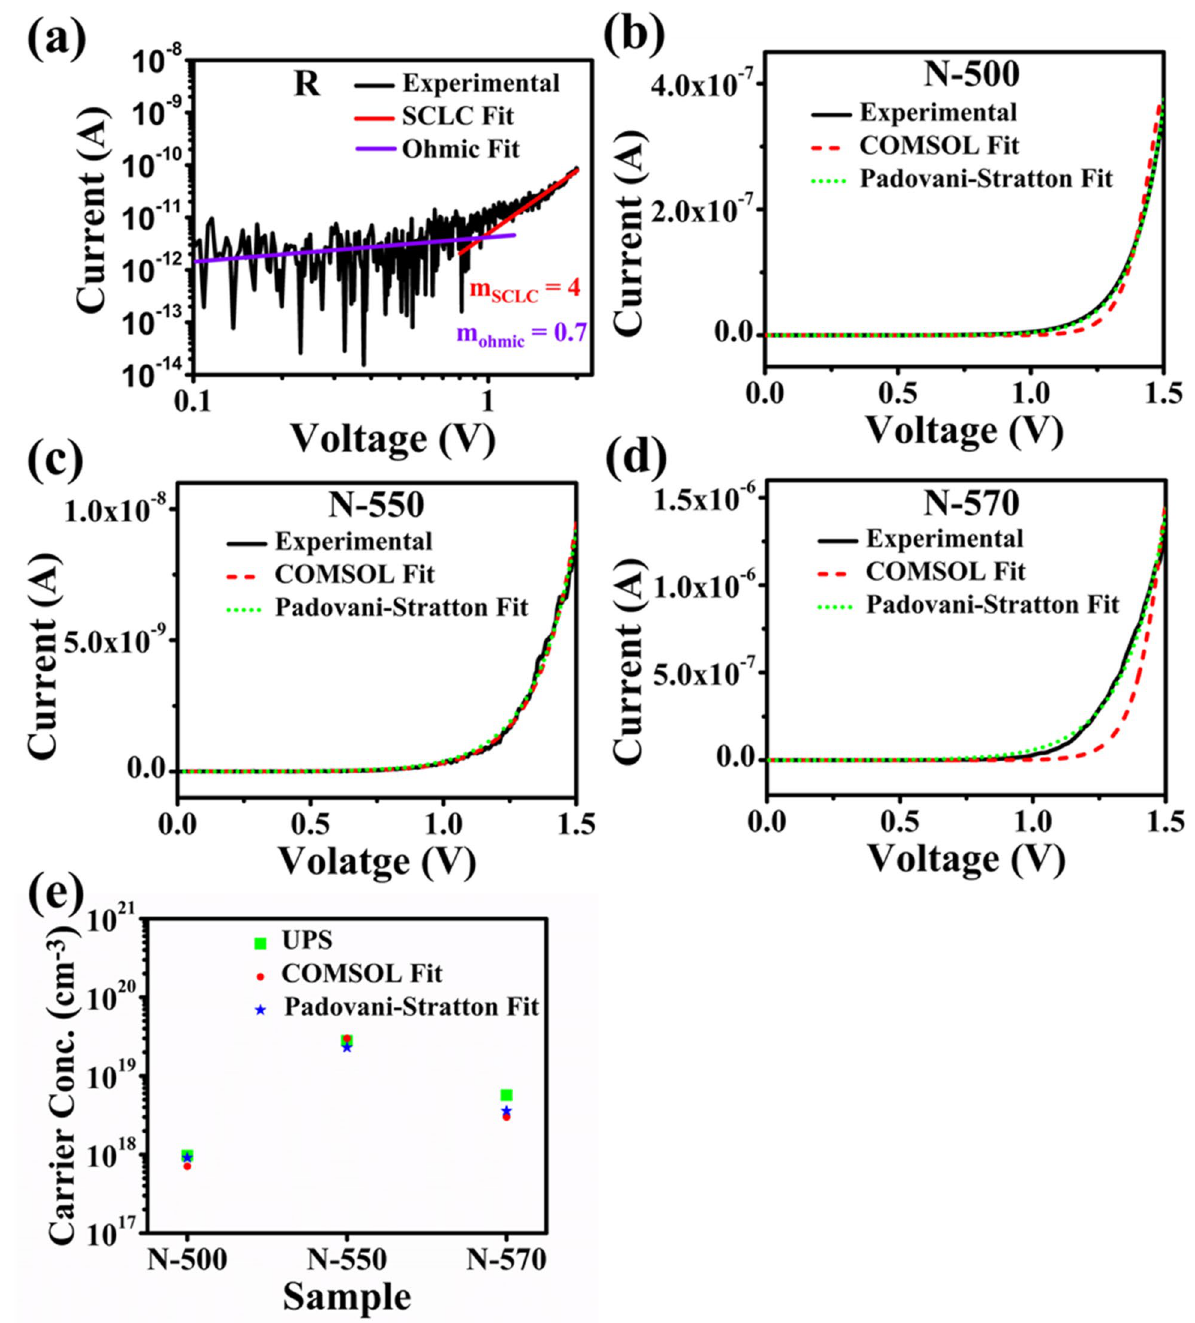
Figure 6. ( a ) Log–log I–V characteristic of R sample exhibiting linear and power dependence, ( b – d ) experimental I–V dark, simulated COMSOL fit, and Schottky diode fitting of dark I–V characteristics of ( b ) N-500, ( c ) N-550, and ( d ) N-570 samples, and ( e ) carrier concentration of N-500, N-550, and N-570 samples extracted from UPS, COMSOL fit, and Padovani-Stratton